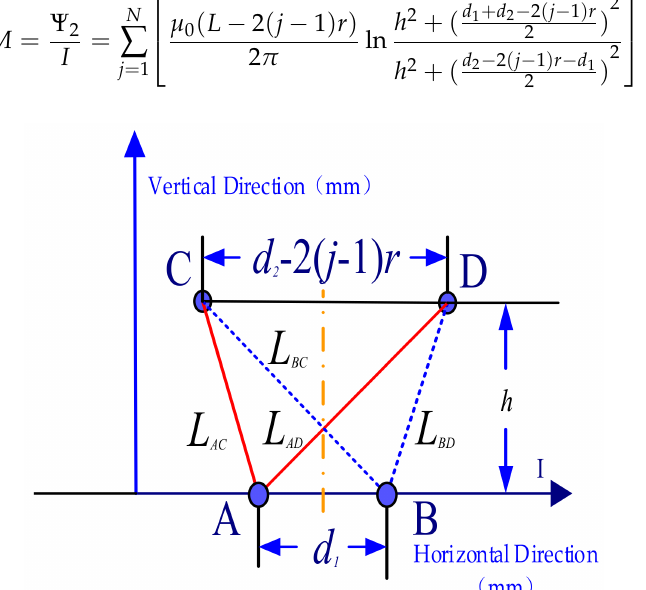
Figure 7. Vertical equivalent diagram between the track and the